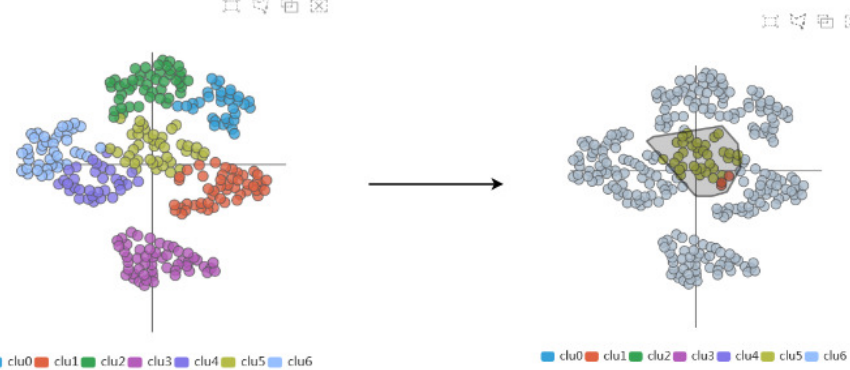
Figure 14. The AAFS Clustering View frame selection process. We can select any region in the AAFS Clustering View, and the corresponding details will be displayed in the AAFS Detailed Clustering View.